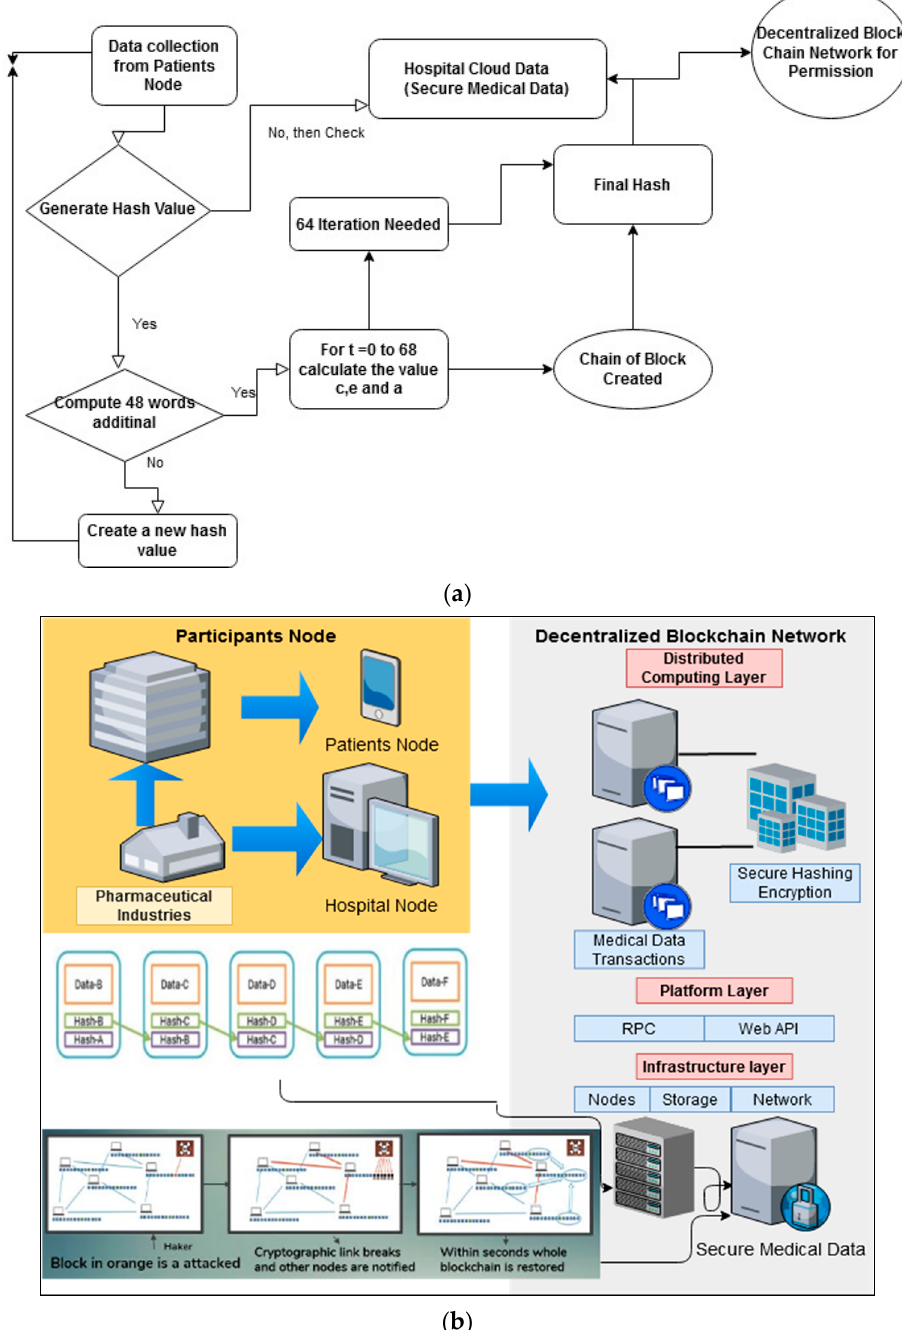
Figure 5. ( a ) Data Flow Diagram of the Proposed Approach. ( b ) The proposed secure architecture for blockchain-based healthcare data